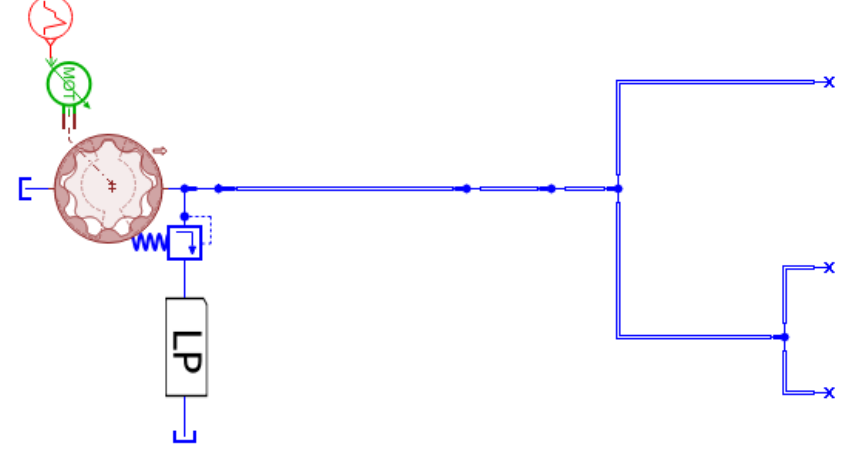
Relief valve (RV010).